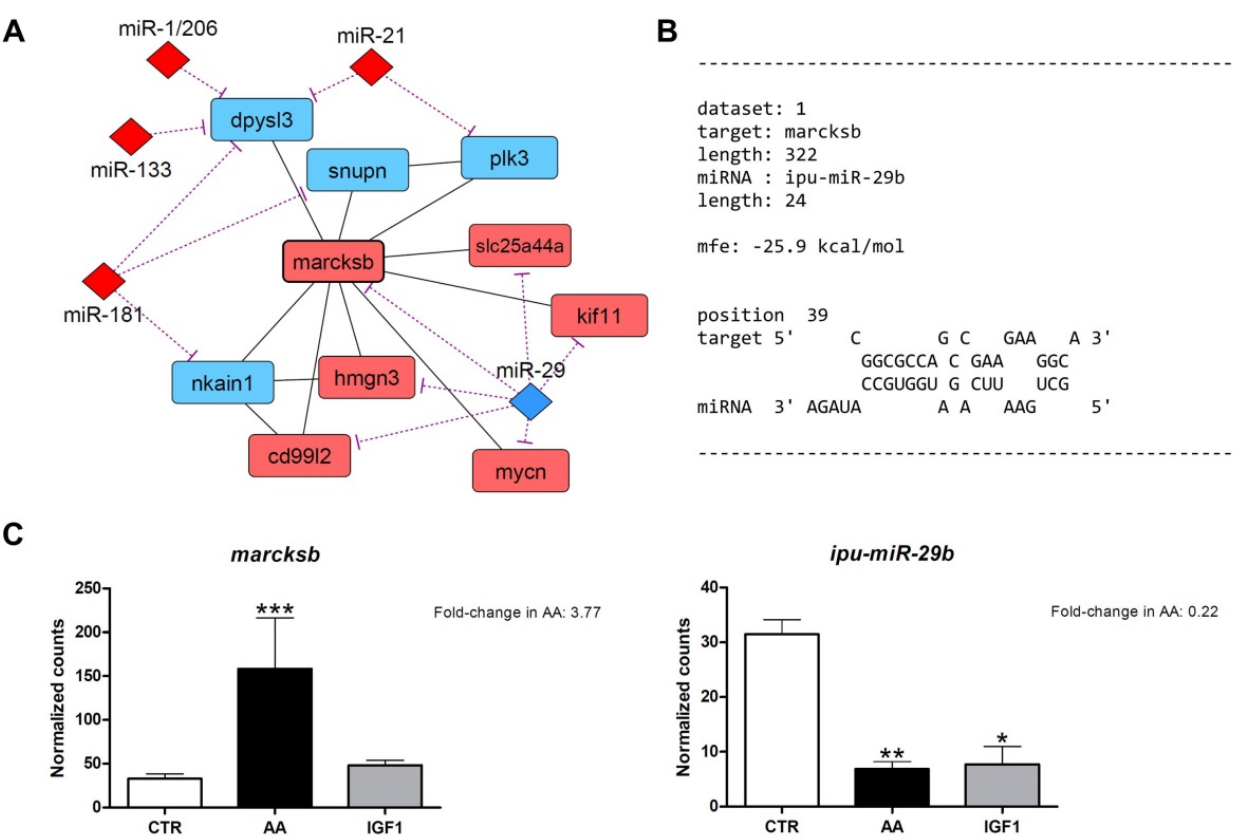
Figure 5. Identification of marcksb as potential target of miR-29b in AA pacu-cultured myotubes. ( A ) Interaction molecular network between marcksb ( myristoylated alanine rich protein kinase c substrate b ), miR-29 and other differentially expressed genes and miRNAs. Up- and down-regulated genes are represented respectively by light red and light blue colors, and up- and down-regulated miRNAs are represented respectively by red and blue colors. Purple lines show interaction between miRNAs and genes, and black lines show interaction between the genes. ( B ) Bioinformatics prediction of the marcksb / miR-29b hybridization. The MFE (minimum free energy) value was within accepted range. ( C ) Gene expression of marcksb and ipu-miR-29b in CTR, AA and IGF1 groups according to the dif- ferential expression analyses. Expression is shown, as number of counts and values represents means ± s.e.m. ( n = 3 independent cell cultures). The fold-changes in AA group are shown in the graphs, and asterisks indicate significant differences between groups: *: p -adj < 0.05; **: p -adj < 0.01; ***: p -adj < 0.001.